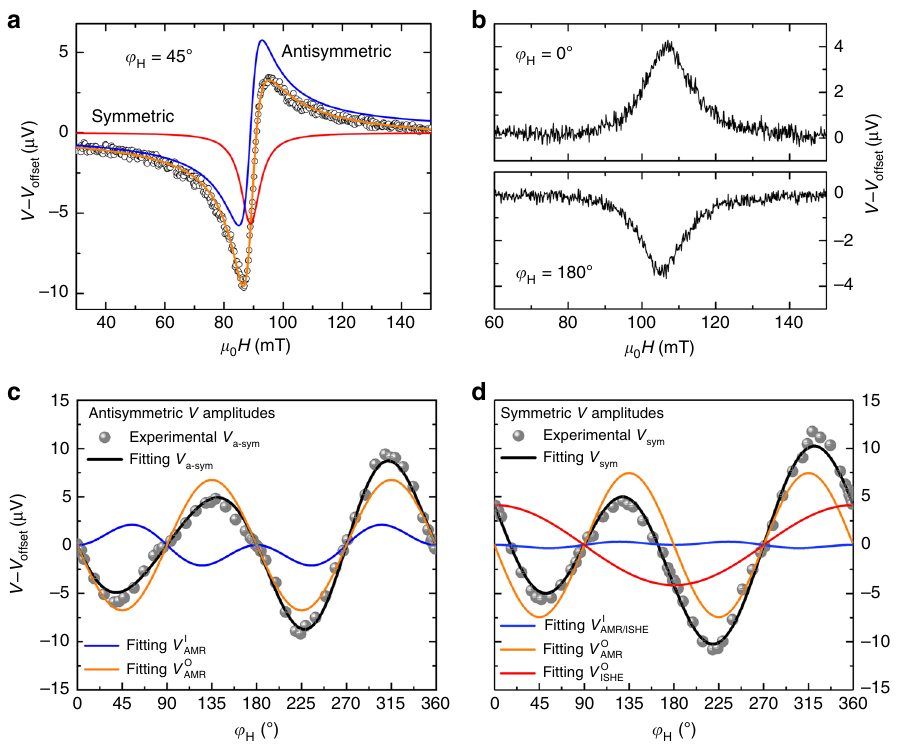
Fig. 2 Angular dependence of d.c. voltages. a d.c. voltage signals obtained at φ H = 45°, where fi tting results include symmetric and antisymmetric parts. b Pure spin pumping voltage signals acquired at φ H = 0° and 180°. c , d Antisymmetric and symmetric voltage signal amplitudes at FMR as a function of angle φ H . All data are recorded at 11 GHz and at 400 K for ferromagnetic FeRh (10)/Pt. The error bars in c and d , which are standard deviations obtained from the fi t of the d.c. voltage spectra, are smaller than the size of the